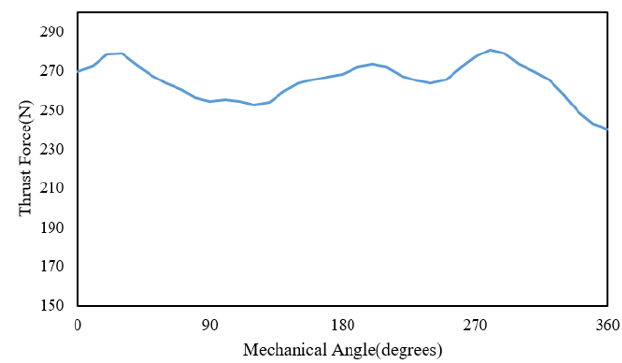
Figure 10. TF at different mechanical